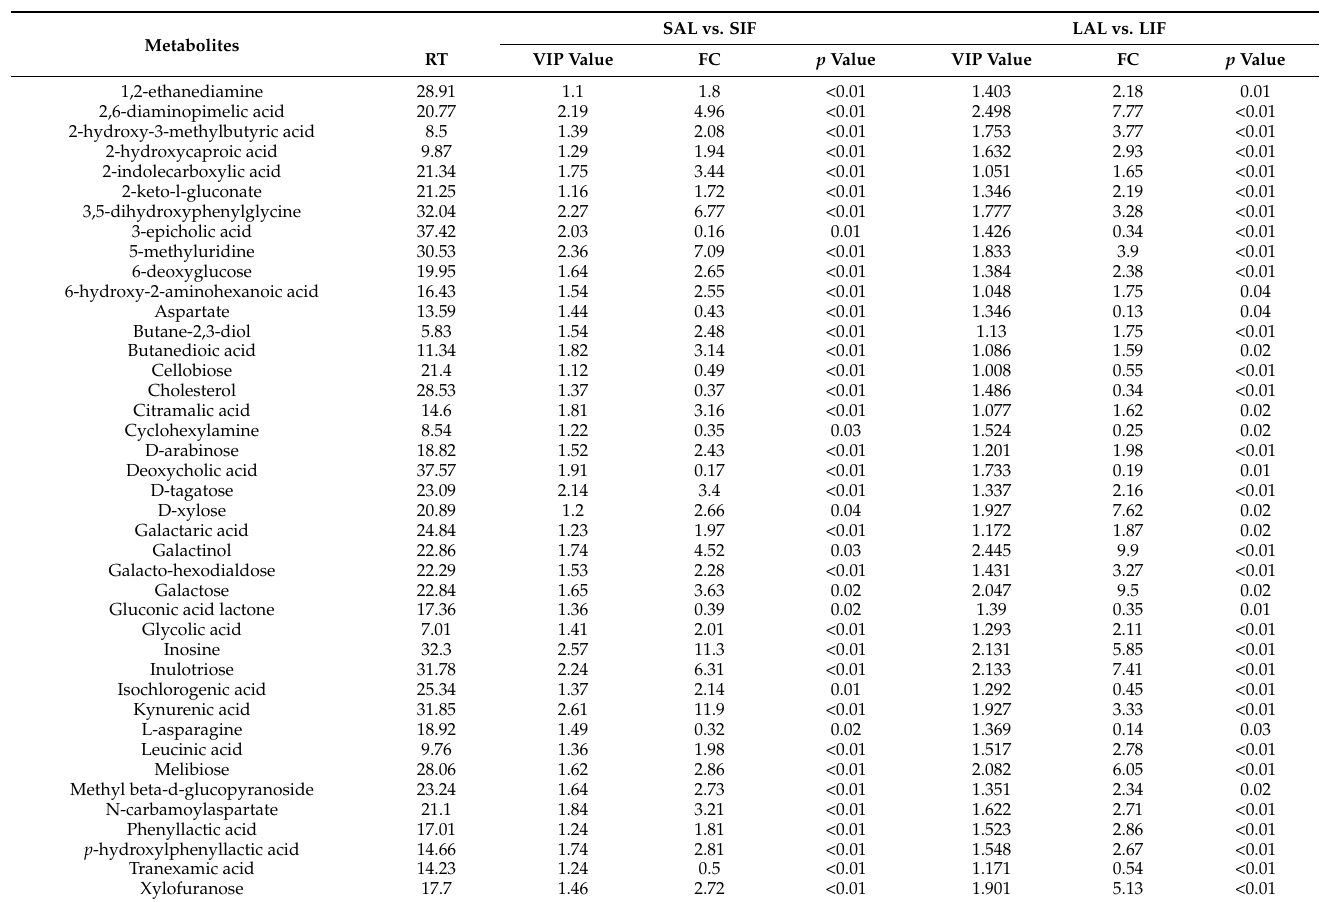
Table 2. Effects of IF on the faecal